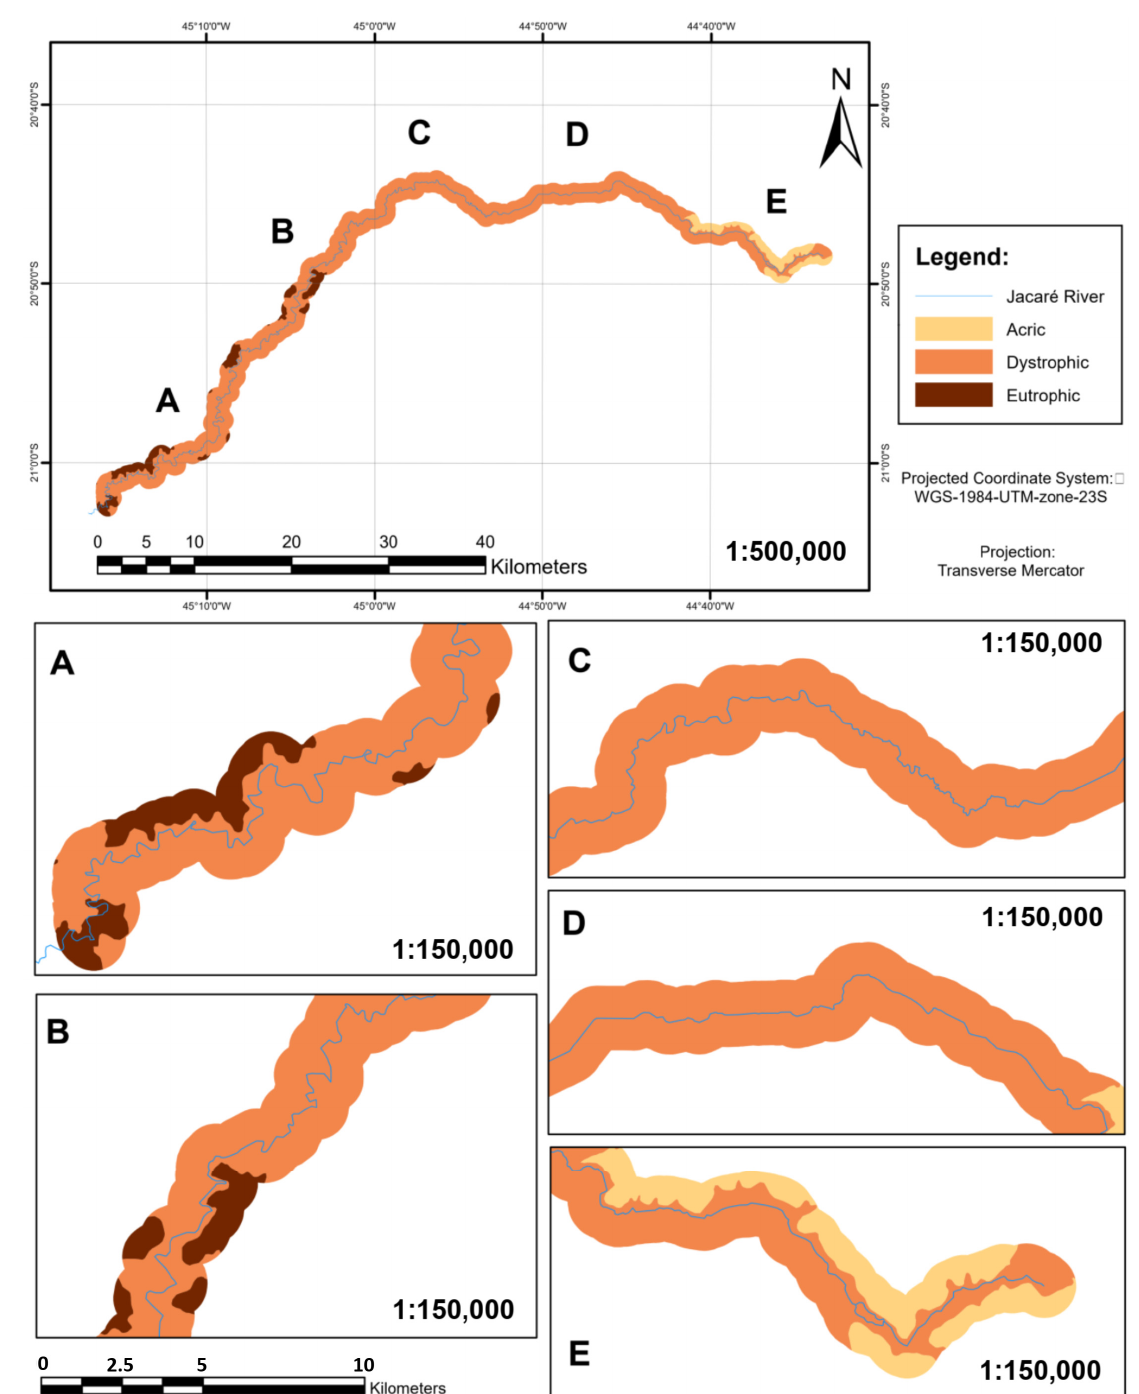
Figure 7. Soil map. ( A – E ) are the regions with the most significant potential for reforestation.